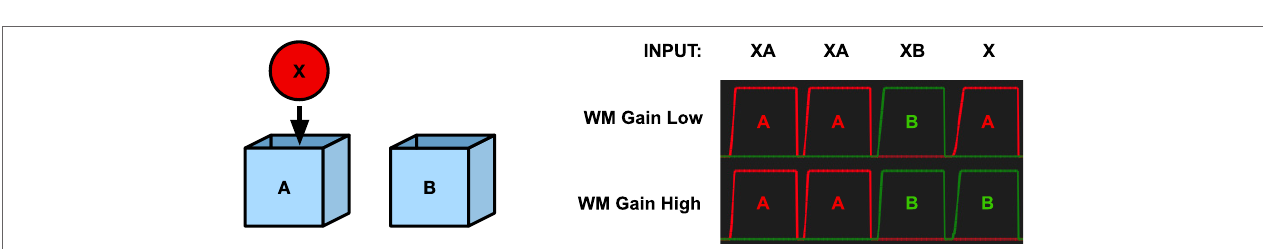
FigUre 5 | Simulation of the object recall for the scene in Figure 4 . The memory system was first shown three combinations of objects and place: AX, BY, and CZ. Next it is cued with each of the locations A, B, and C. The graph at the top shows the activation of each place code over time. The graph at the bottom shows the path through the memory space as each location is cued. The state is initially wandering, which results in transitions 1 and 2 just before the system is cued with A.